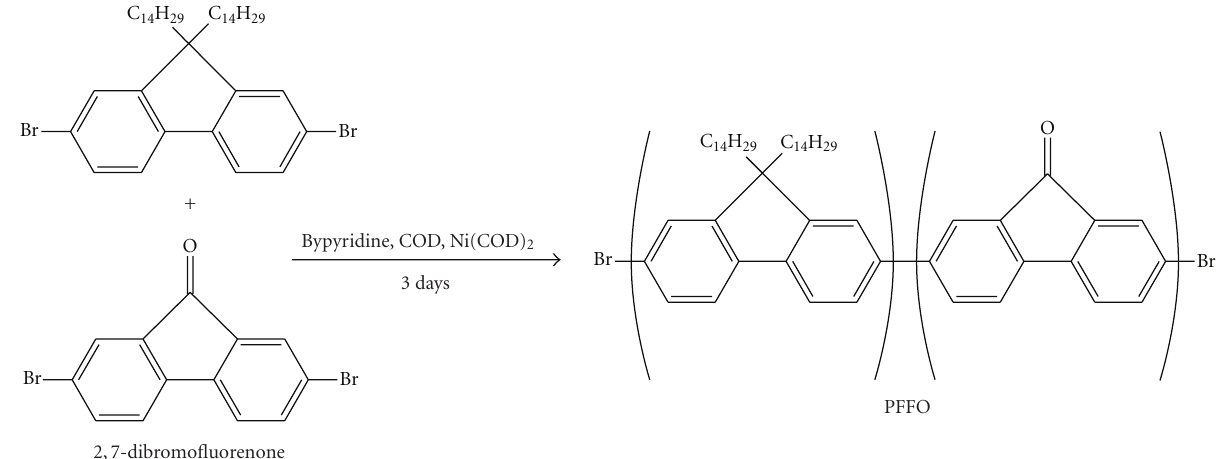
Figure 1: Polymerisation of modified 2,7-dibromofluorene and 2,7-dibromofluorenone monomers by Yamamoto